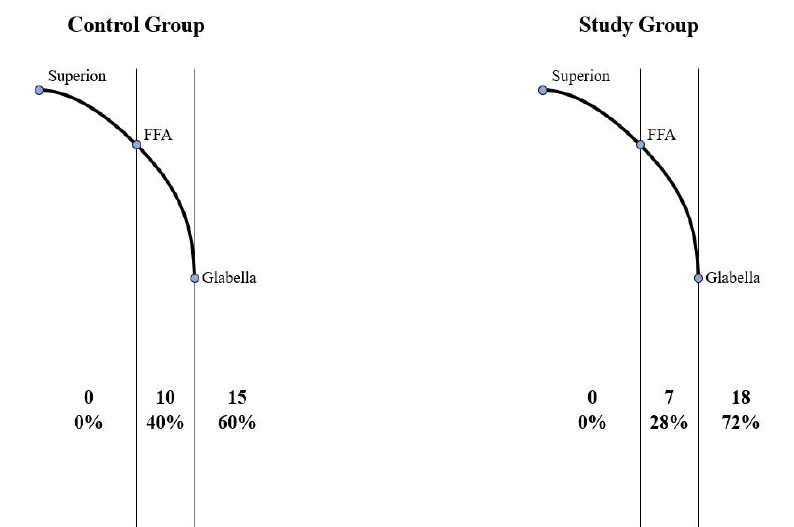
Figure 4. Distribution of the anteroposterior maxillary central incisor positions relative to the forehead for the control and study groups. FFA: forehead facial axis.